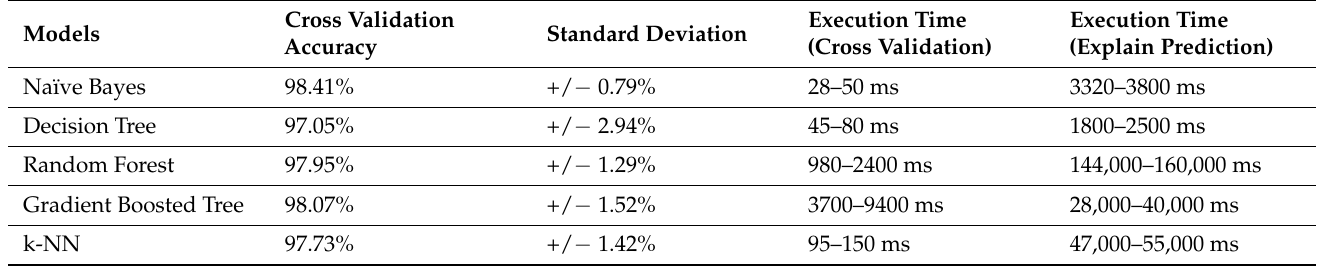
Table 5. Results comparisons obtained from the RapidMiner